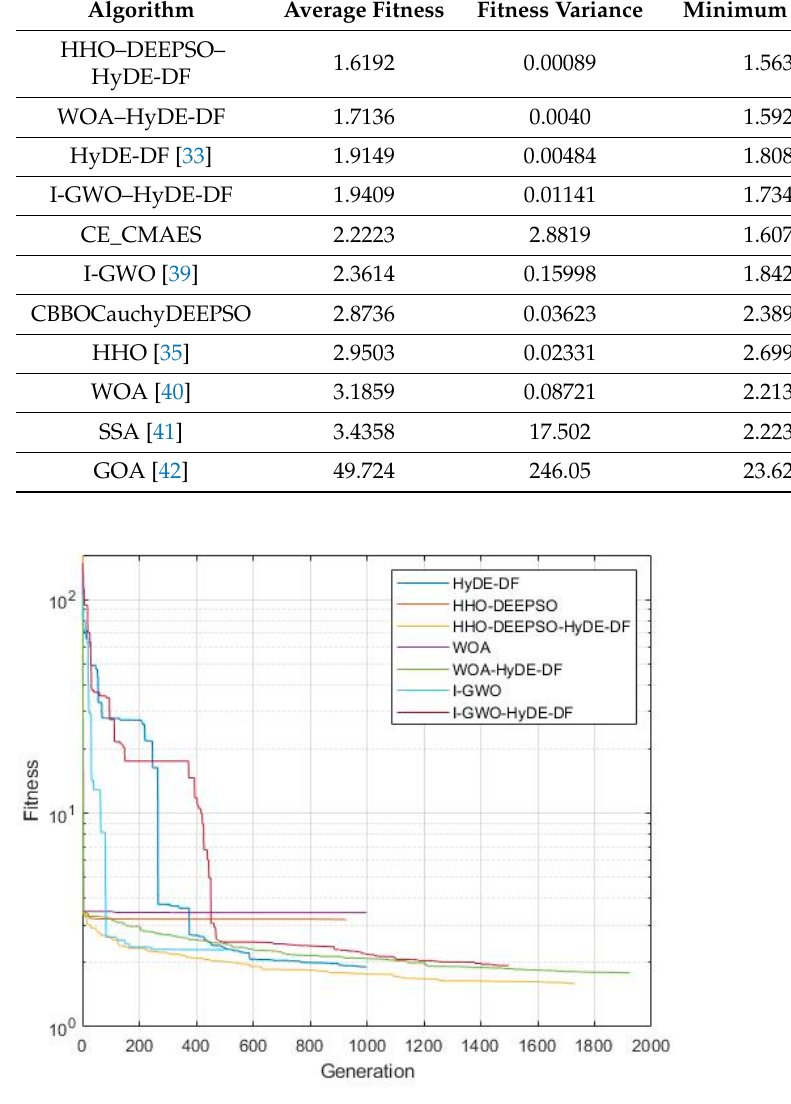
Figure 4. Fitness evolution for some tested algorithm.